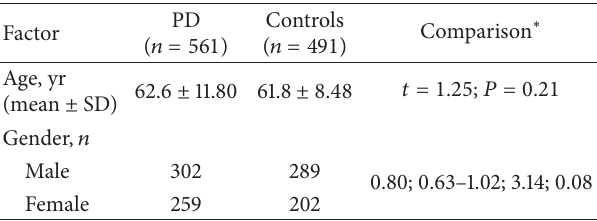
Table 1: Demographic data for Han Chinese with Parkinson’s disease (PD) and healthy